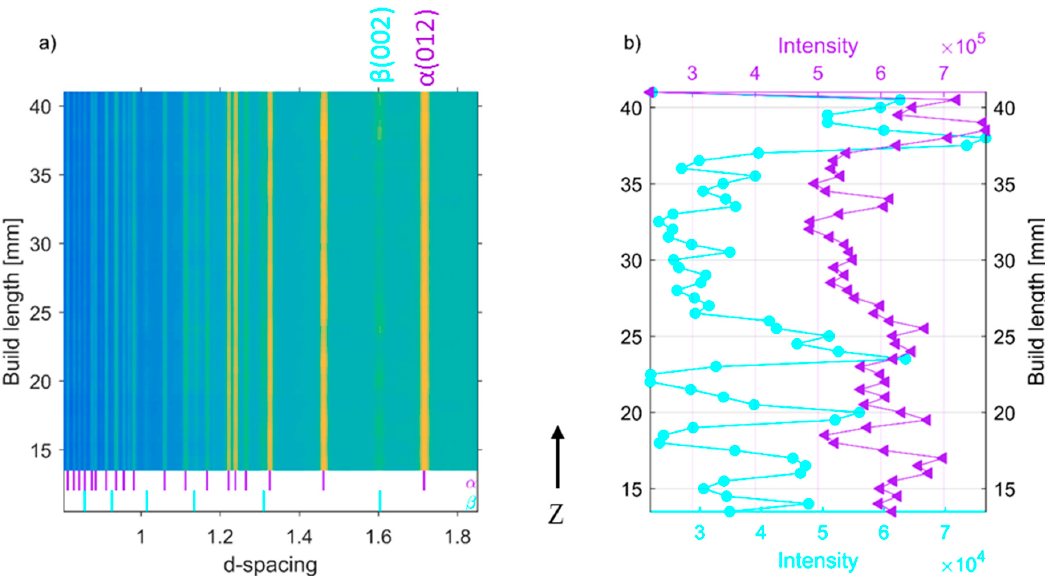
Figure 6. ( a ) Accumulated diffraction patterns of vertical line scan along the build direction of specimen S8, and ( b ) corresponding peak intensity of (002) β‐ Ti (magenta) and (012) α‐ Ti. (purple).